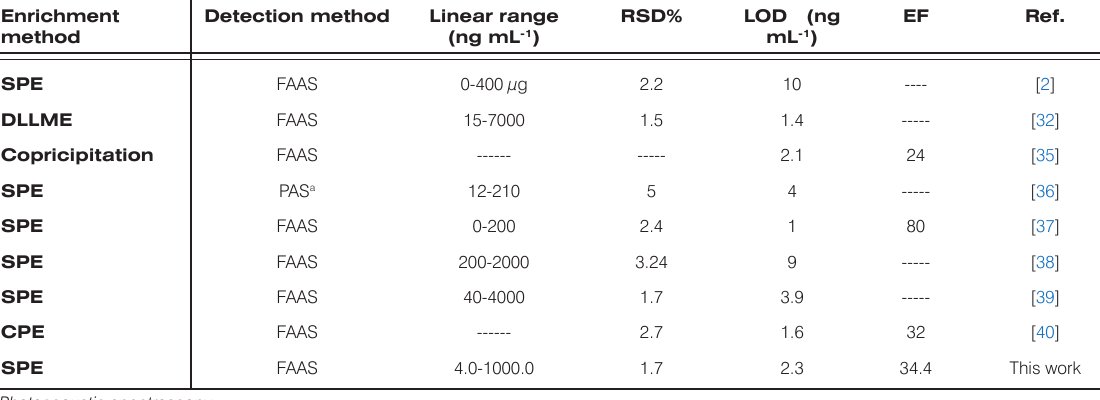
Table 5. Comparison of the SPE procedure with the other method reported in the